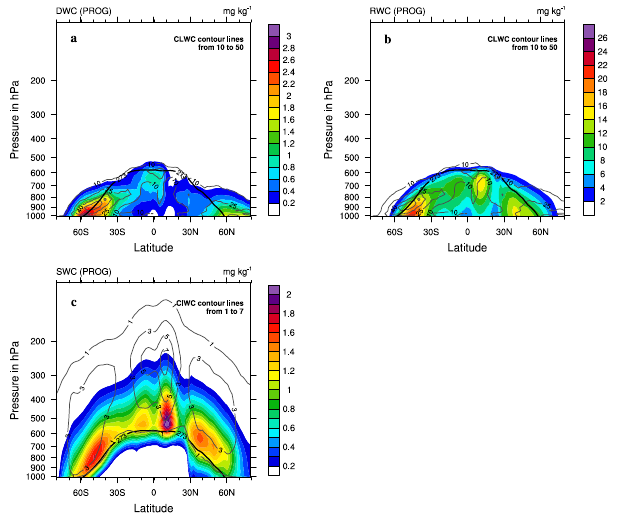
Figure 6. Annual mean precipitation water contents from PROG of (a) drizzle and (b) rain with the contour lines of the CLWC, such as (c) snow with the contour lines of the CIWC and the melting line (solid black line).